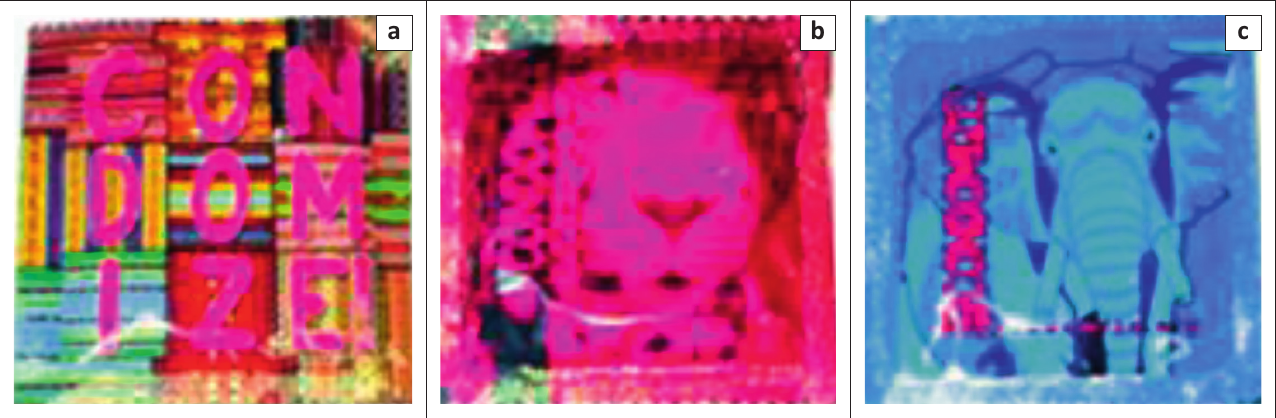
FIGURE 1: Photo’s of (a) Condomize regular, (b) flavoured and (c) extra-large.